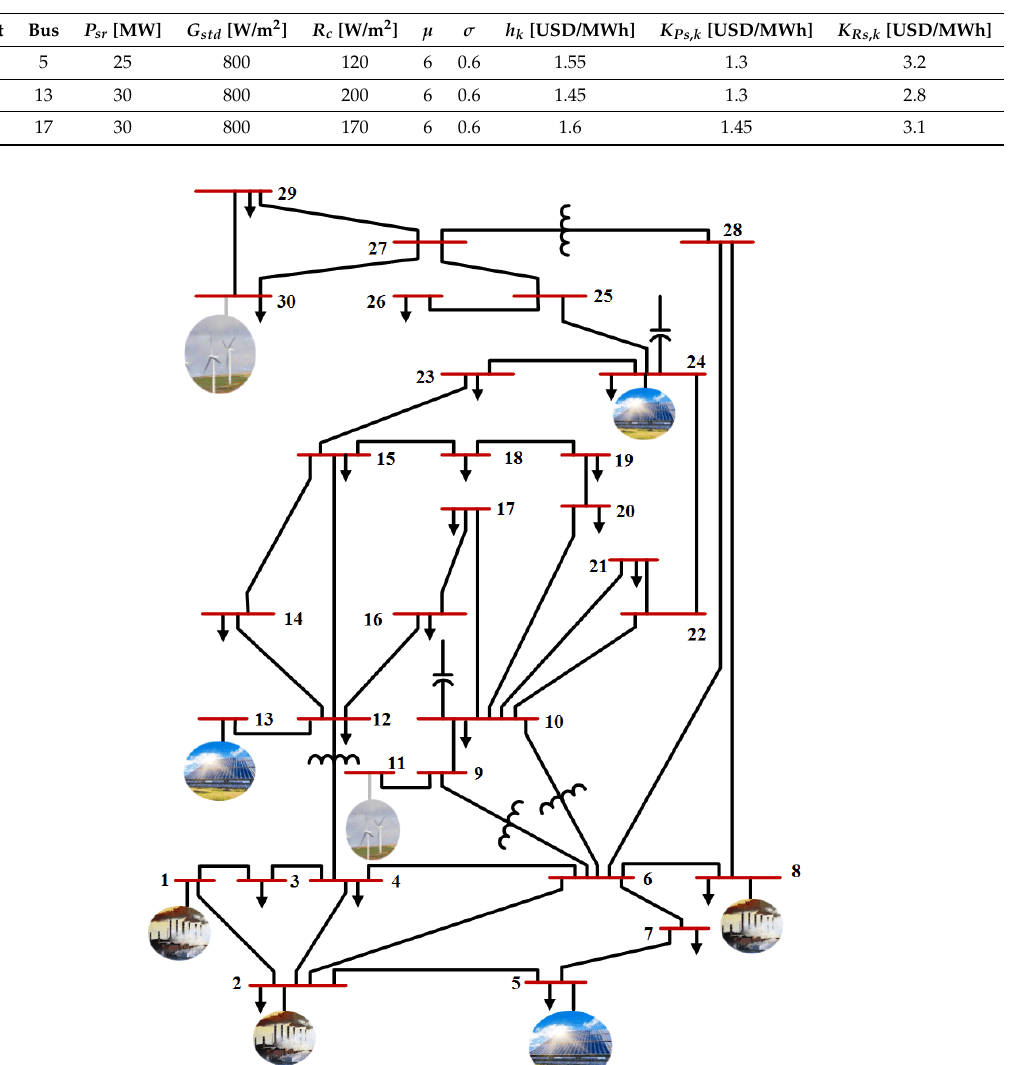
Table A5. Data for solar PV plant for IEEE 30-bus Modified (2).